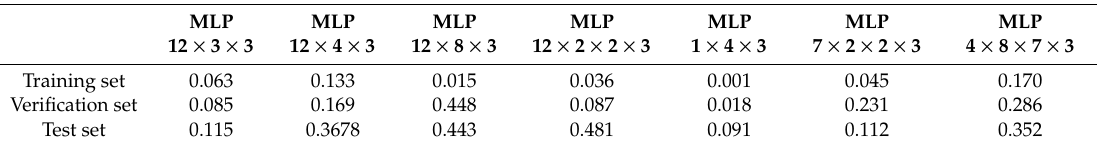
Table 4. Calculated root-mean-squared (RSM) errors for the seven multilayer perceptron (MLP) architectures compared in the